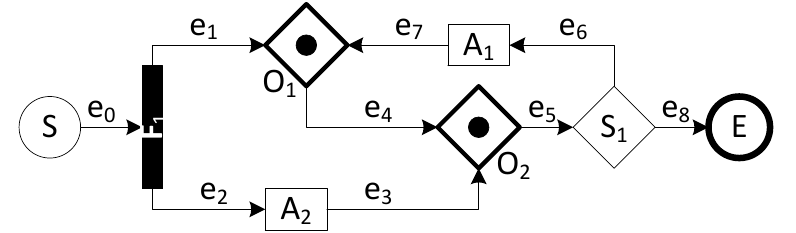
Figure 5. Workflow graph of the process in Figure 1